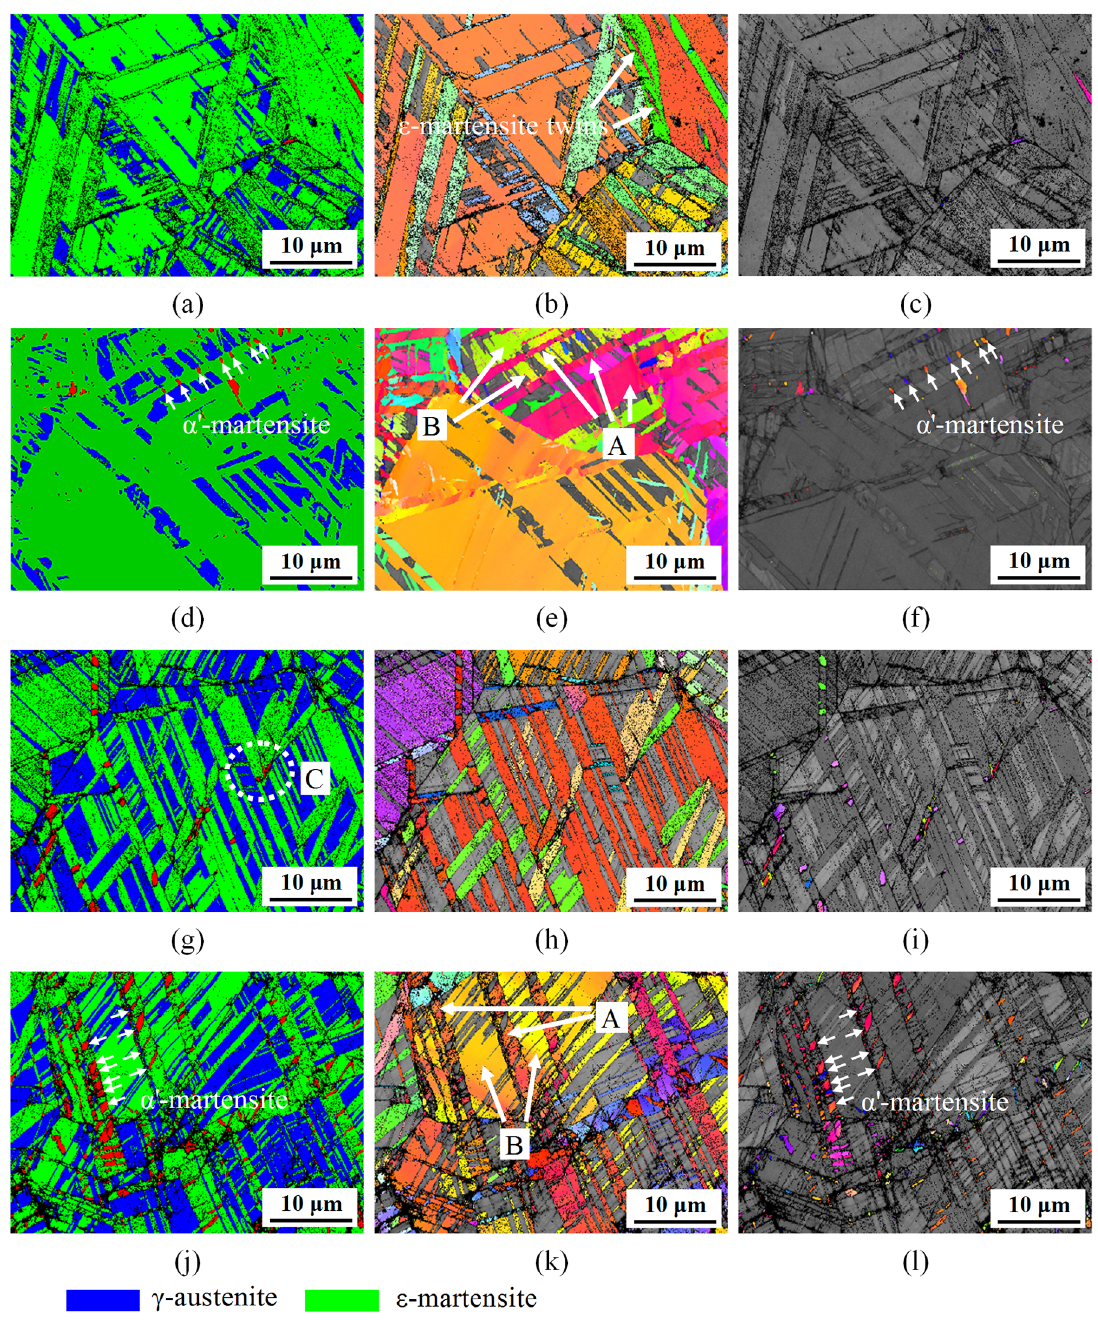
Figure 6. EBSD analysis on (a)-(f) the Fe-19Mn alloy and (g)-(l) the Fe-19Mn-8Cr-1Co-0.2Si alloy after cold rolling: (a)-(c) and (g)-(i) 5% deformation; (d)-(f) 8% deformation; (j)-(l) 10% deformation; (a), (d), (g) and (j) the phase maps; (b), (e), (h) and (k) the inverse pole figure maps of ε-martensite; (c), (f), (i) and (l) the inverse pole figure maps of